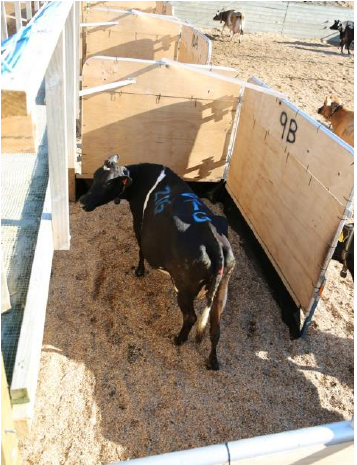
Figure 2. Birds’ eye view of hides constructed from two interlinked gates and covered in plywood and rubber sheeting. Spring-loaded metal foot supported the outer gate, and two aluminum crossbars inserted via a dowel kept the gates open.